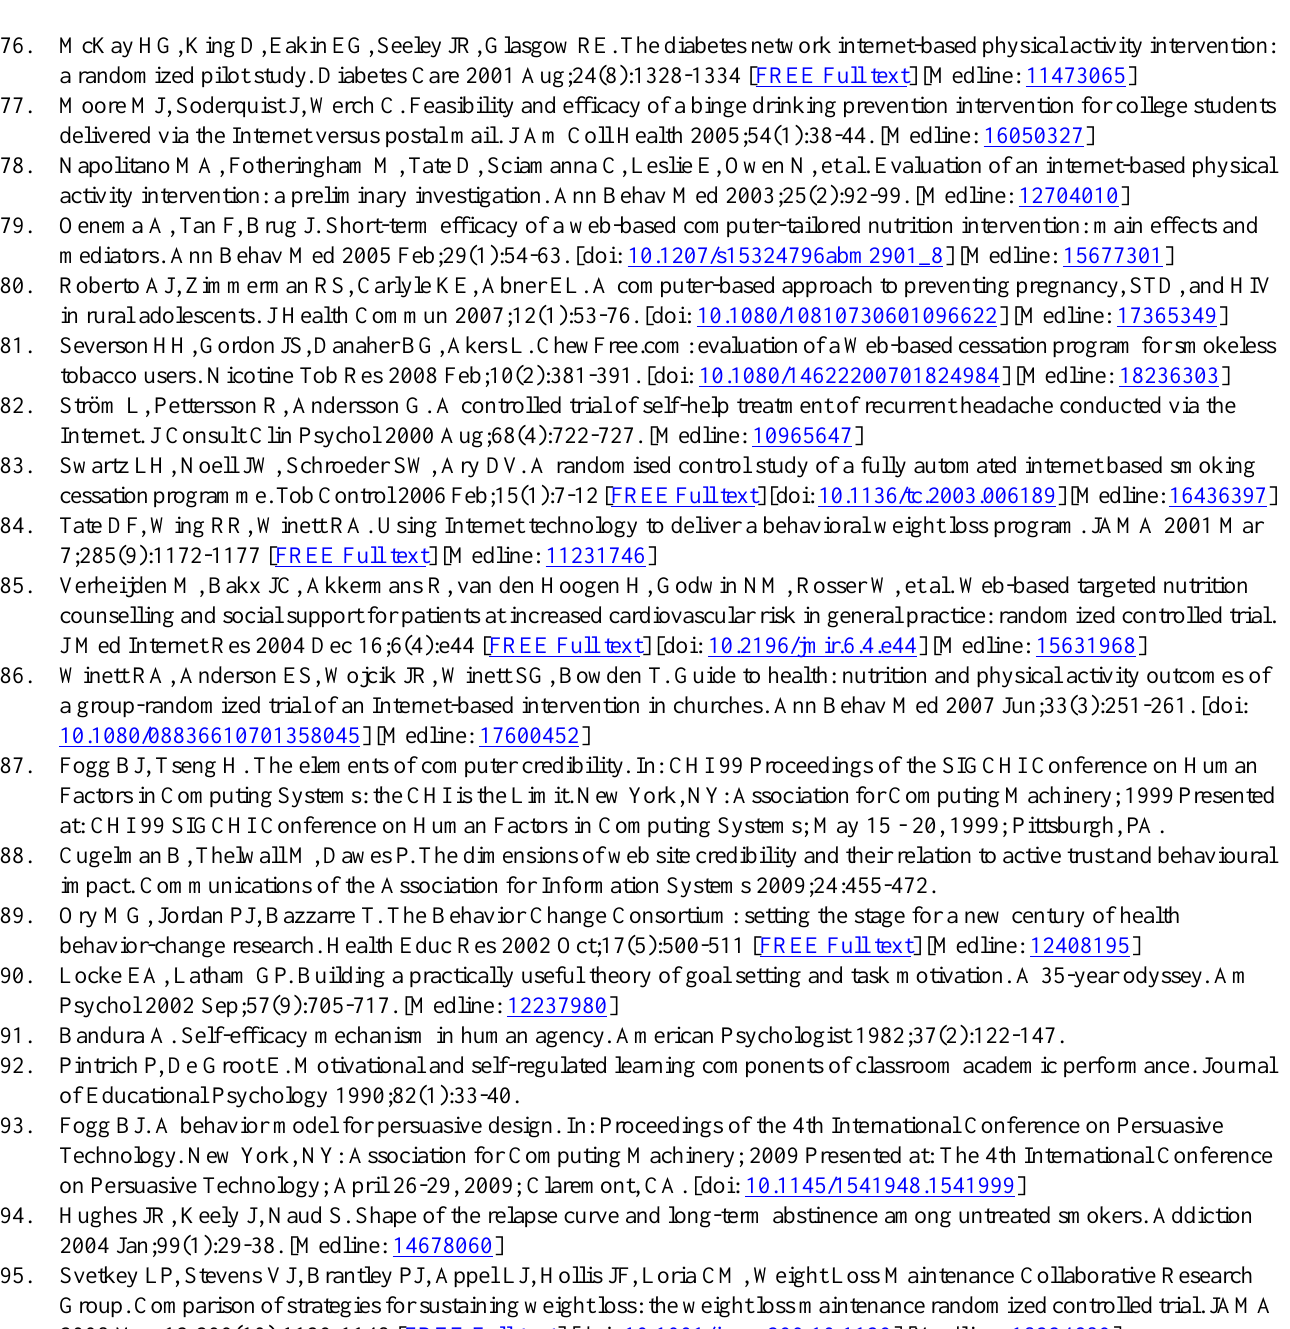
Abbreviations ANOVA: analysis of variance CBICM: communication-based influence components model CI: confidence